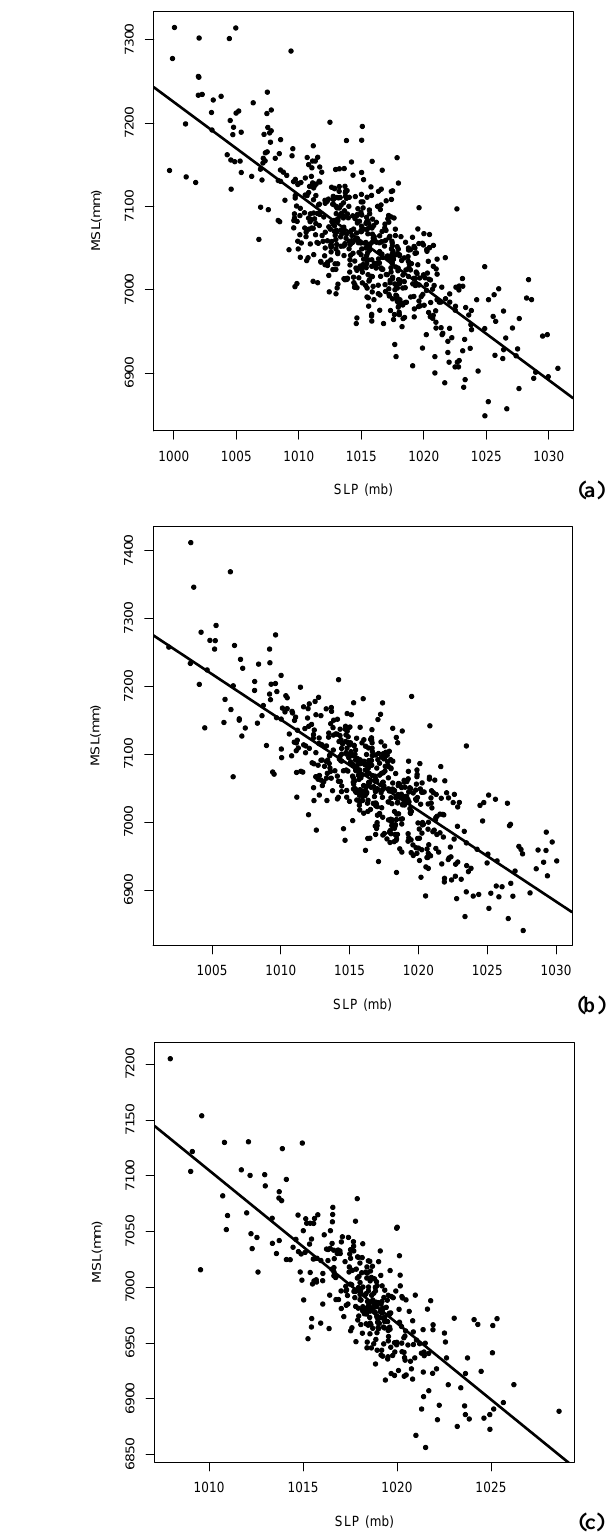
Fig. 2. Cumulative periodograms for MSL time series. (a) Newlyn, (b) Brest and (c) Cascais.